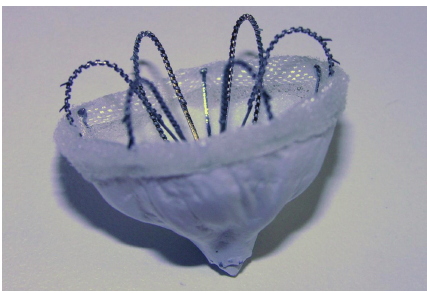
Figure 4: Coherex Wave Crest. (Image courtesy of Coherex Medi-